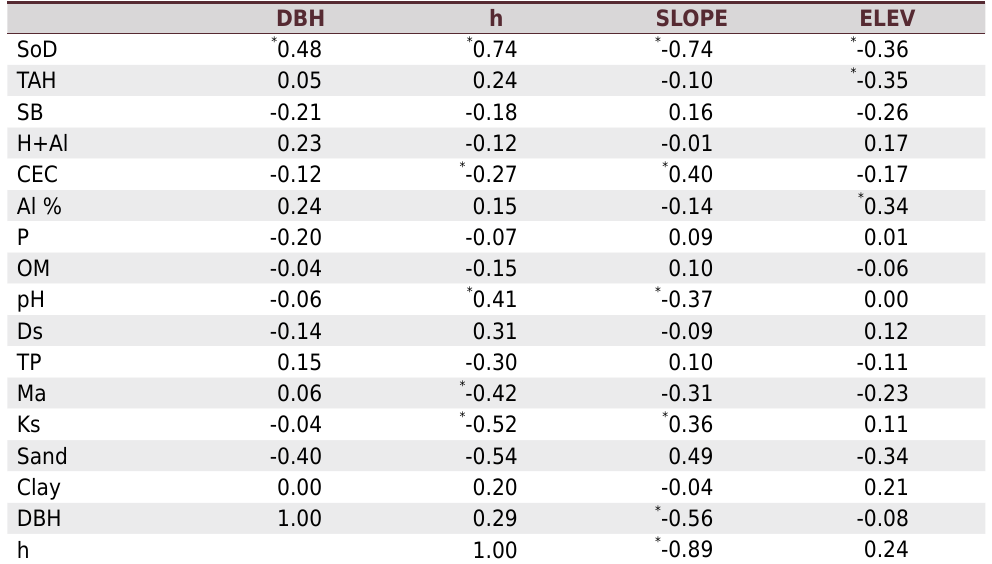
Table 5. Significant Spearman’s correlation coefficients between dendrometric, topographic, and pedological variables of soil dataset 1